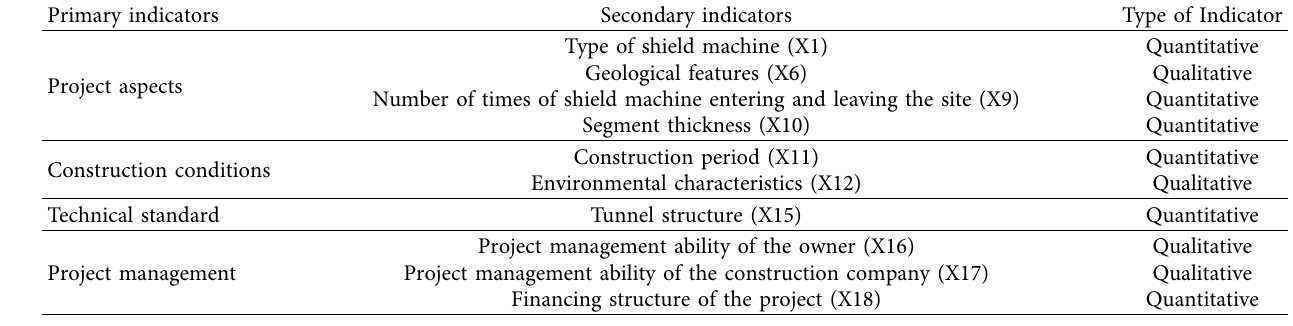
Table 2: The indicators affecting the metro tunnel construction